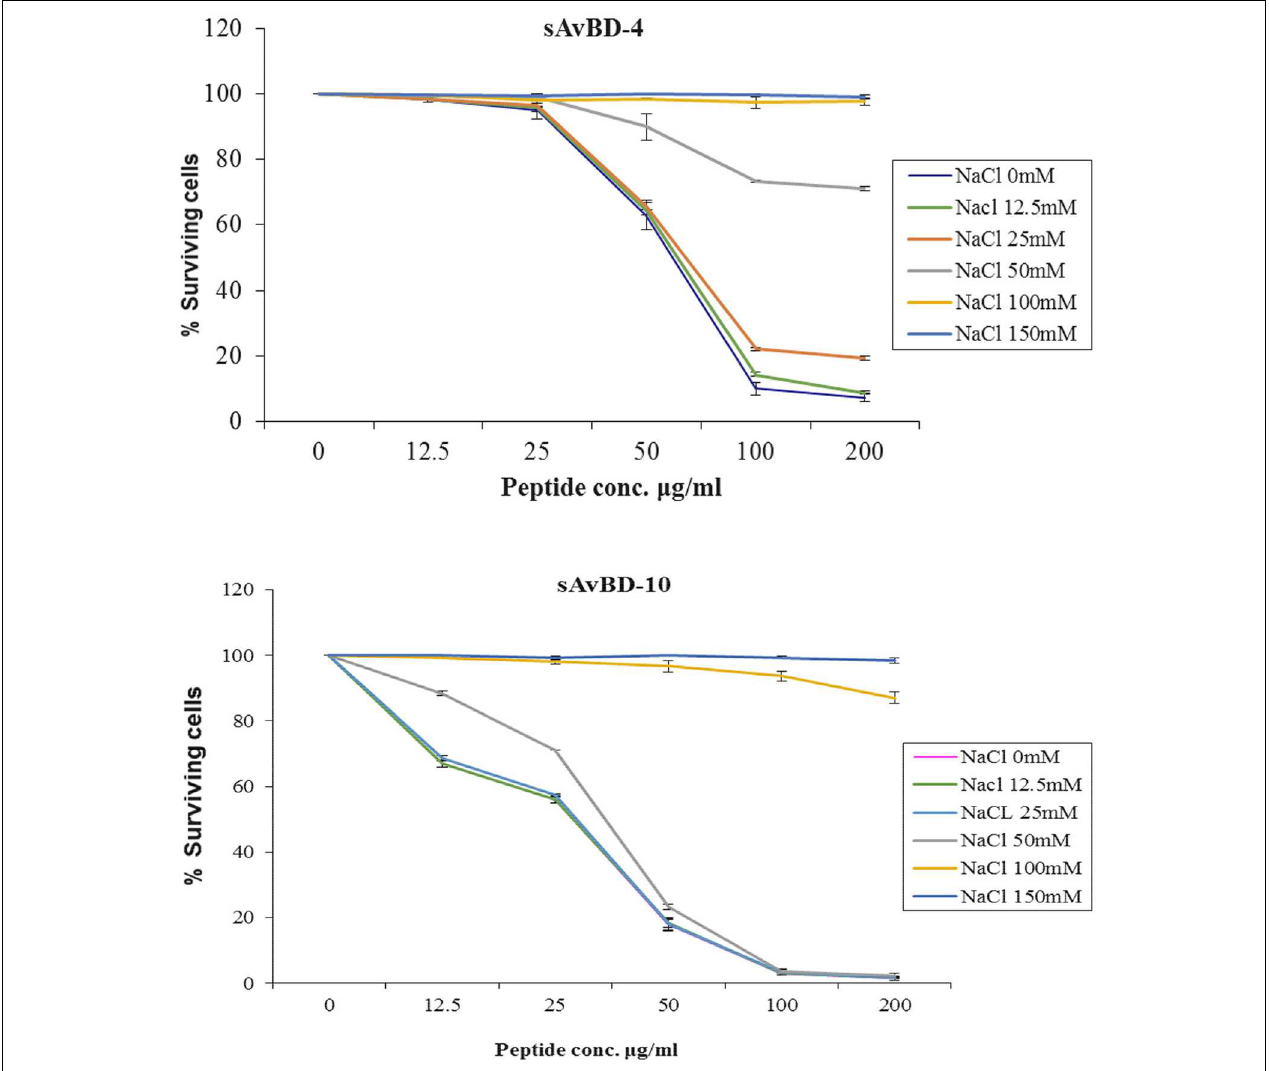
FIGURE 3 | Effects of salinity on the antibacterial activity of synthetic chicken β -defensin-4 and 10-derived peptide (sAvBD) against E. coli . All assays were performed in three independent experiments and each point is the mean ± SE, ( P < 0 . 001 ).